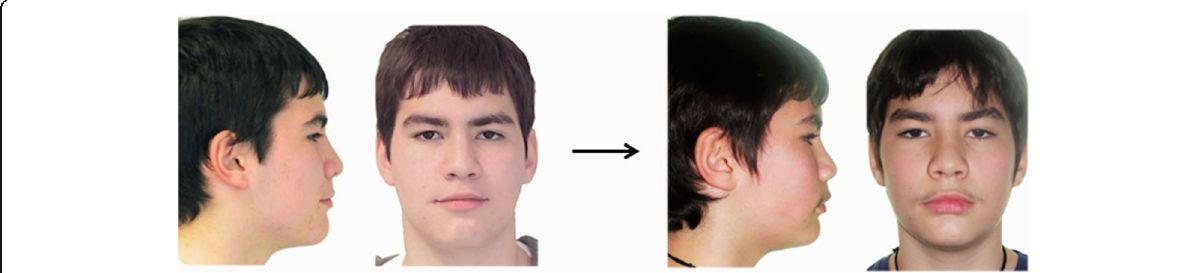
Fig. 1 Photographs of a selected patient as presented to raters. The post-treatment photograph is presented to the left and the pre-treatment photograph to the